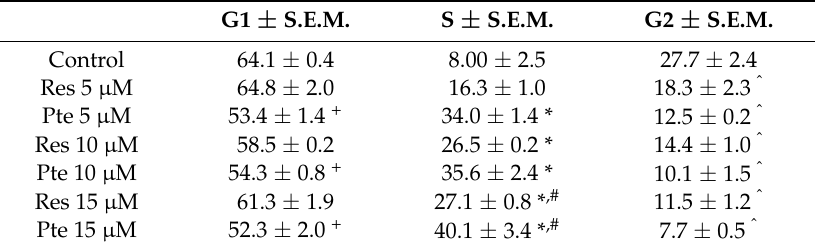
Table 1. Table showing the percentage of cells in each phase of the cell cycle (% ± S.E.M.) after treatment with different concentrations of resveratrol (Res) and pterostilbene